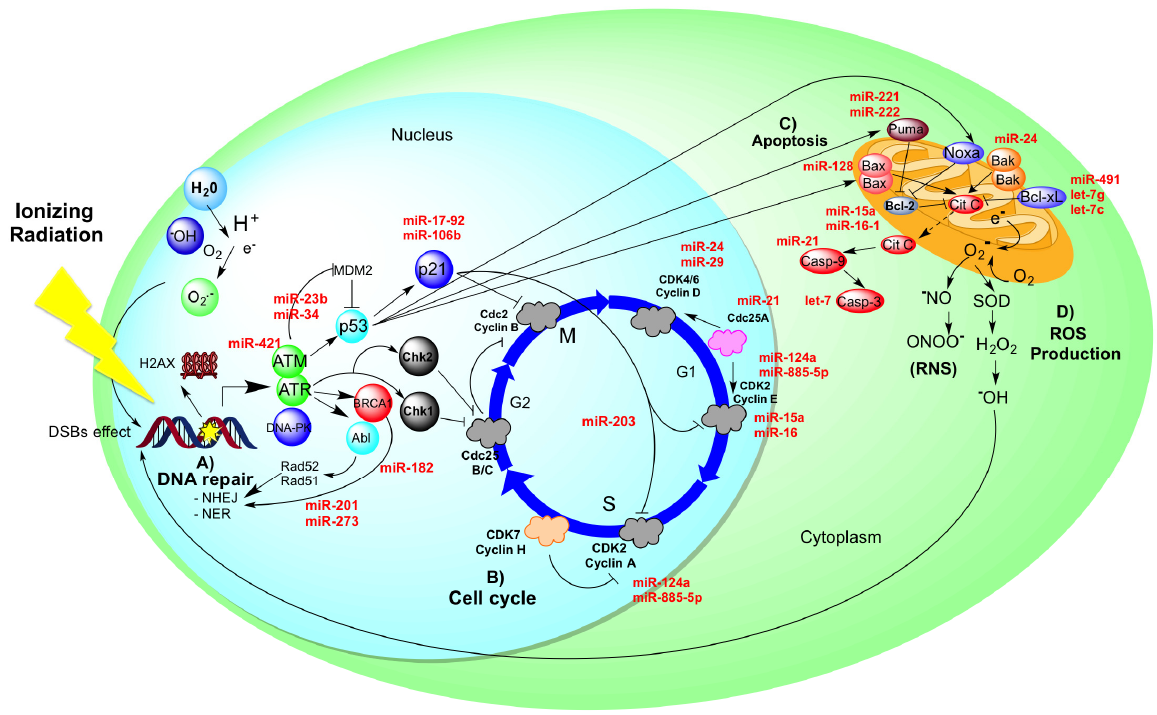
Figure 3. Major molecular process regulated in radioresistant tumor